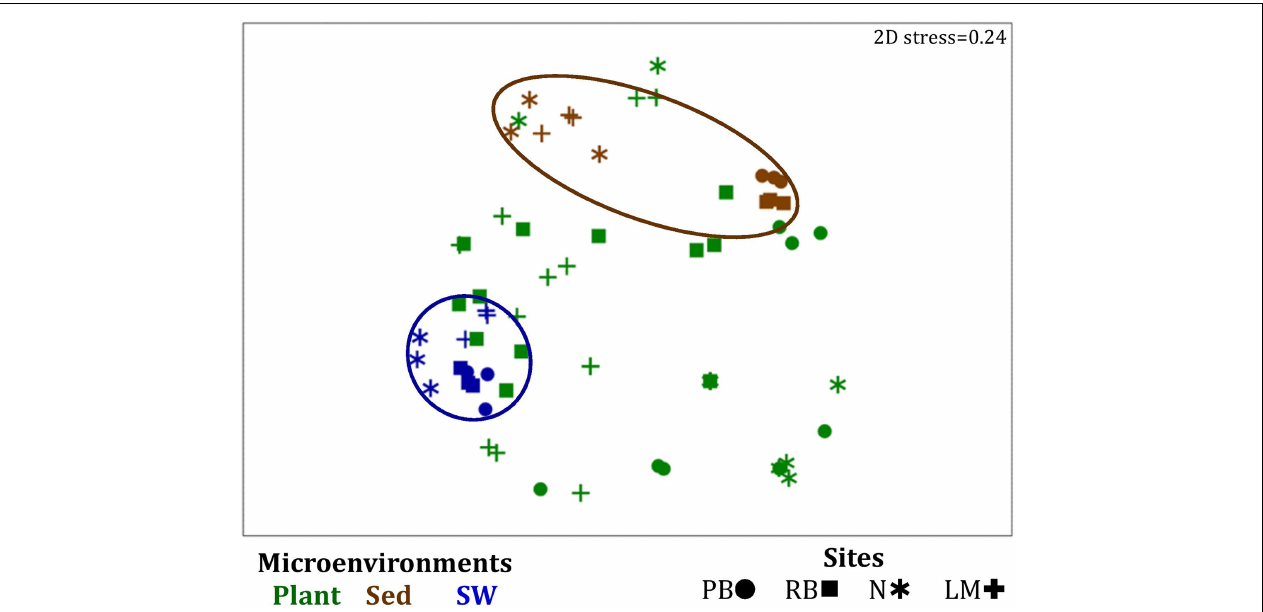
FIGURE 7 | Microenvironmental and regional partitioning of the seagrass microalgal microbiome. Non-parametric multidimensional scaling (nMDS) of microalgal microbiomes ( n = 72), based on a lower triangular resemblance calculated with the S17 Bray–Curtis similarity measure from relative abundances of OTUs (high values down-weighted with square root). Samples are colored by microenvironment (Plant: upper leaf, lower leaf, sheath and roots and rhizomes; Sed, sediment, SW, seawater), with different shapes for sites (PB, Palm Beach; RB, Rose Bay; N, Narrabeen Lagoon; LM, Lake Macquarie). Sample clustering patterns by microenvironment are shown in ellipses in the nMDS plot, representing the level of similarity between samples based on the degree to which OTUs are shared between them. The 2D stress is shown in the upper right corner of the nMDS plot (Kruskal stress formula = 1, minimum stress = 0.01). A hierarchical cluster analysis (CLUSTER) for all samples is provided in Supplementary Figure 4 and the nMDS for the four microenvironments associated with the plant is provided in Supplementary Figure 5 .